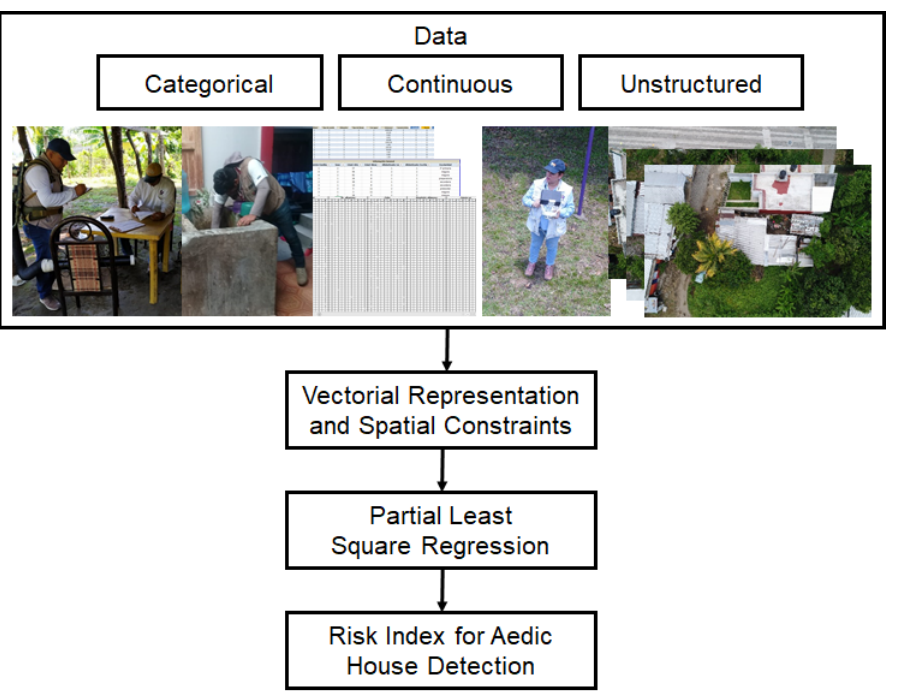
Figure 2. Block diagram of the proposed